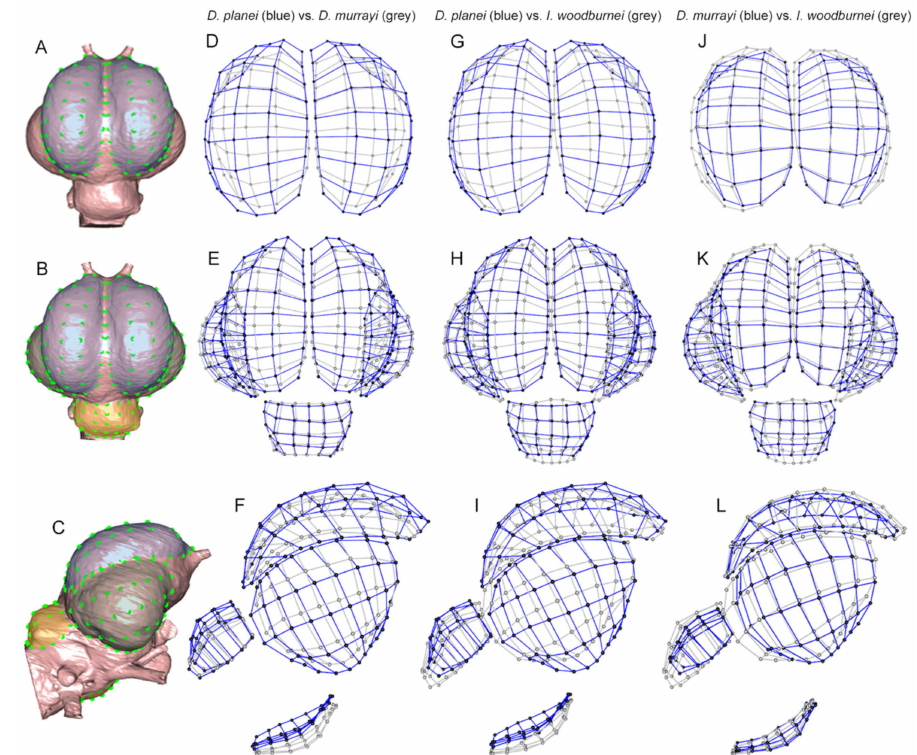
Figure 5. Three-dimensional modular shape variation plots for dromornithid specimens (see Section 2.7.2). ( A ), Dromornis planei (NTM P9464-106) endocast showing the caudodorsal view of the wulst (grey) Slm modules represented in plots ( D ), ( G ), and ( J ); ( B ), D. planei (NTM P9464-106) endocast showing the dorsal view of the wulst (grey), caudal telencephalon (green) and cerebellum (yellow) Slm modules represented in plots ( E , H , K) ; ( C ), D. planei (NTM P9464-106) endocast showing the right lateral view of the wulst (grey), caudal telencephalon (green), cerebellum (yellow), and rhombencephalon (brown) Slm modules represented in plots ( F , I , L ). Modular Slms (green dots) are mapped onto the inset endocasts, and modules are colour-shaded to assist identification (see Figure 2; SI Figures S10 and S11). Shape variation plots are arranged by column (see column header): ( D – F ), D. planei (NTM P9464-106–blue) vs. D. murrayi reconstruction (QM F57984 + QM F57974–grey); ( G – I ), D. planei (NTM P9464-106–blue) vs. Ilbandornis woodburnei (QVM:2000:GFV:20–grey); ( J – L ), D. murrayi reconstruction (QM F57984 + QM F57974–blue) vs. I. woodburnei (QVM:2000:GFV:20–grey). Abbreviations: Slm, semilandmark; vs.,